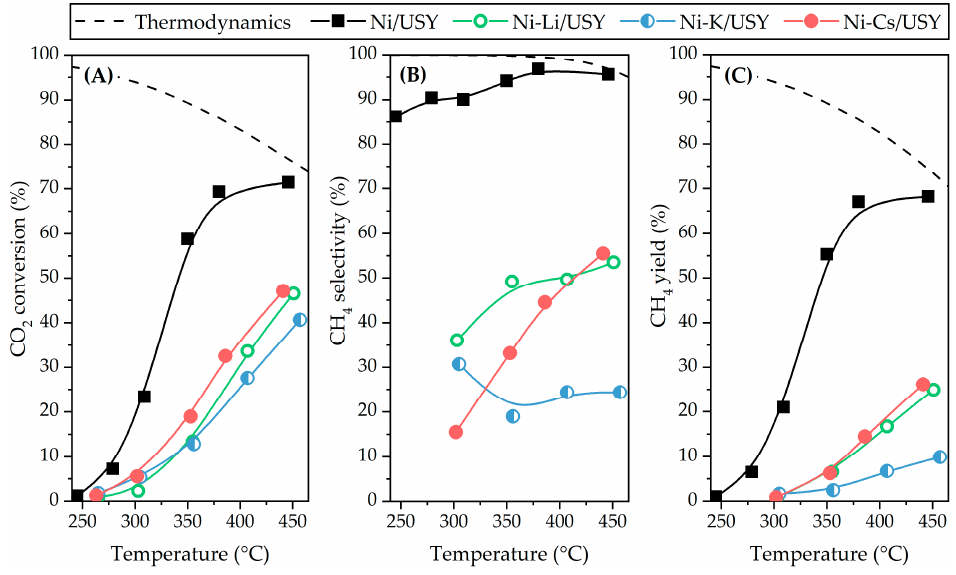
Figure 4. Catalytic performances obtained for Ni-A/USY catalysts after reduction at 470 °C: ( A ) CO 2 conversion; ( B ) CH 4 selectivity and ( C ) CH 4 yield. Operating conditions: 1 bar, 86 100 mL h − 1 g cat − 1 and CO 2 :H 2 :N 2 = 9:36:10.